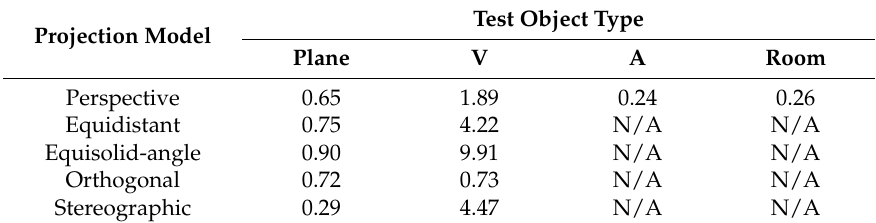
Table 12. RMS-residuals of lens distortion (pixel).